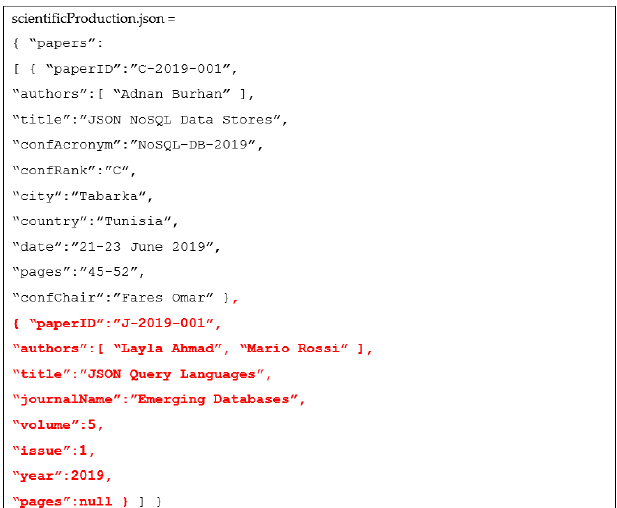
Figure 2. State of the “ scientificProduction.json ” JSON file after the execution of the InsertObject HLO that adds the new (journal) paper.